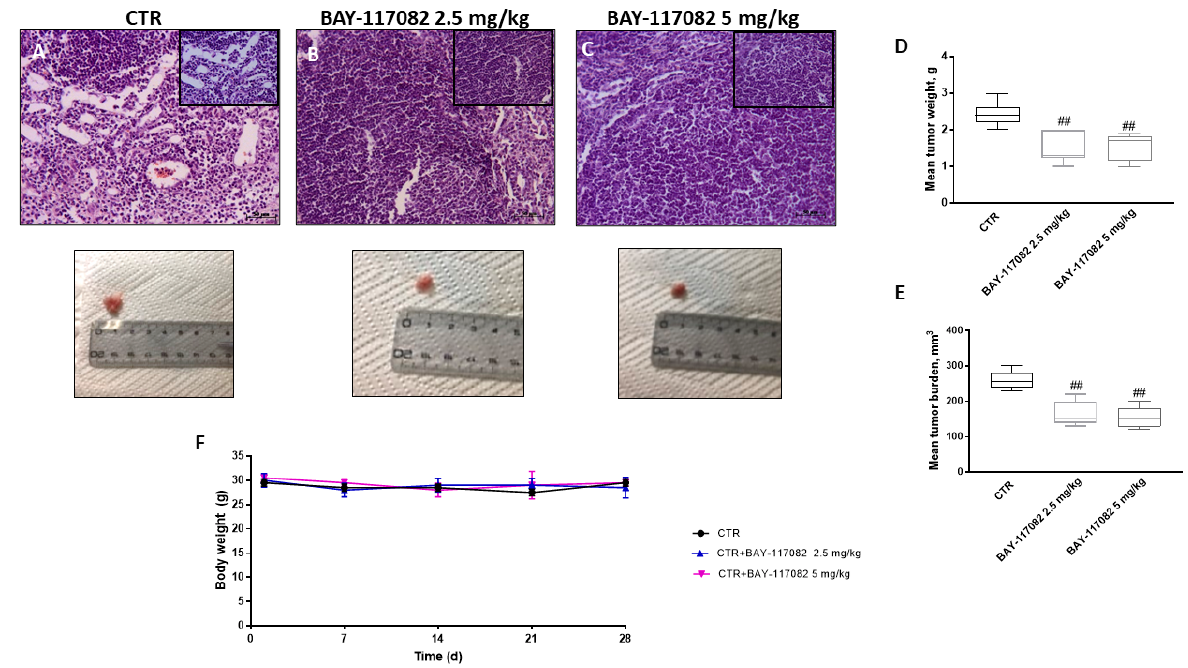
Figure 7. Effect of BAY-117082 on tumor growth in CAL27 xenograft model. ( A – C ) BAY-117082 treatment at doses of 2.5 and 5 mg/kg was able to significantly reduce subcutaneous tumor mass compared to control group. ( D , E ) Additionally, BAY-117082 reduced tumor burden and tumor weight, ( F ) without important weight differences between animals. Data are representative of at least three independent experiments. Sections were observed and photographed at 20 × and 40 × magnification. ( D ) ## p < 0.01 vs. CTR; ( E ) ## p < 0.01 vs. CTR.